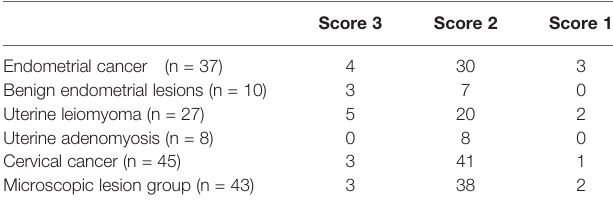
TABLE 2 | MTR image quality evaluation.